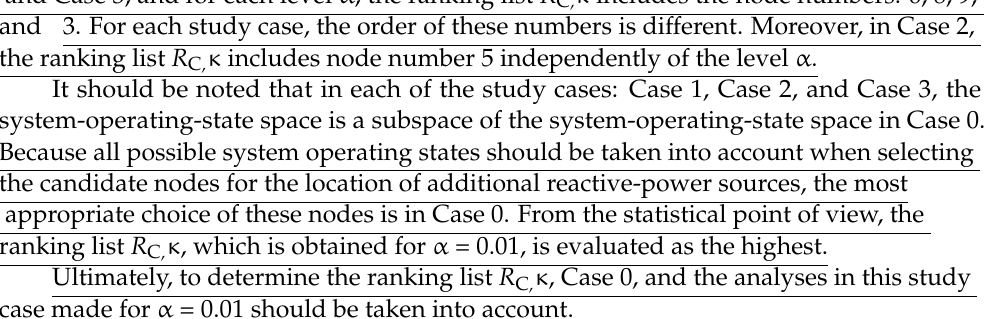
Analyzing Table 27, we can see that for each of the study cases: Case 0, Case 1, Case 2, and Case 3, and for each level α , the ranking list R C , κ includes the node numbers: 6, 8,